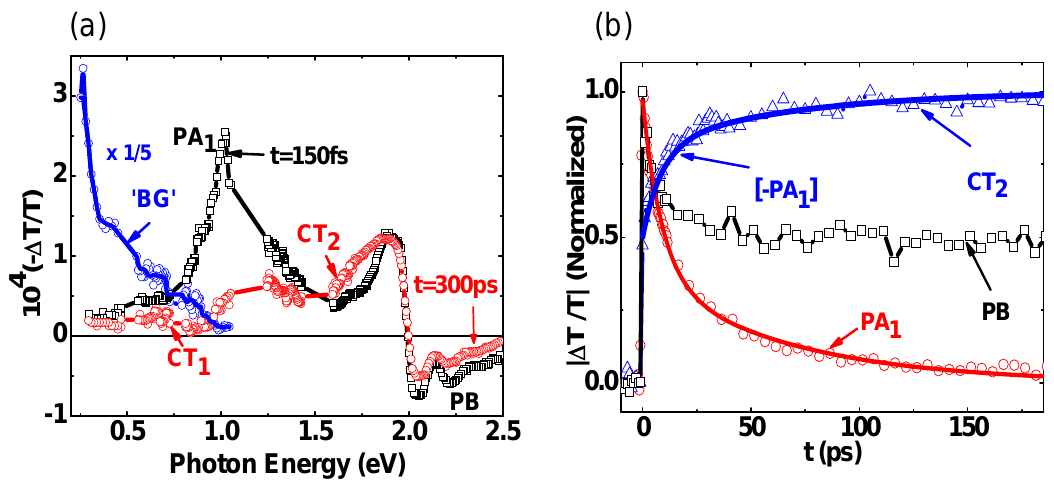
Figure 3. (color on line) ( a ) The transient photomodulation spectrum of RR-P3HT/PCBM blend film at t = 0 and t = 300 ps, respectively; the exciton band PA bands CT and CT are indicated. The blue circles and line represent the background (BG) 1 2 PA spectrum measured at t = − 5 ps; ( b ) The transient decay of PA CT , and the PB decay up to 180 ps. The line through the data points is a fit using the 2 Förester resonant energy transfer (FRET) mechanism (see text); the same function also fits the CT build-up 2